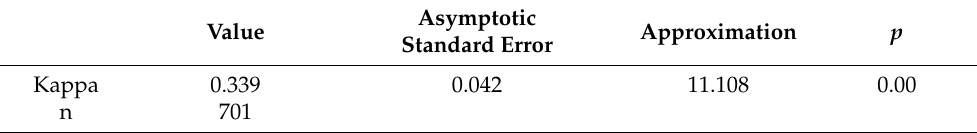
Table 8. Kappa coefficient consistency test for BMI and BIA body